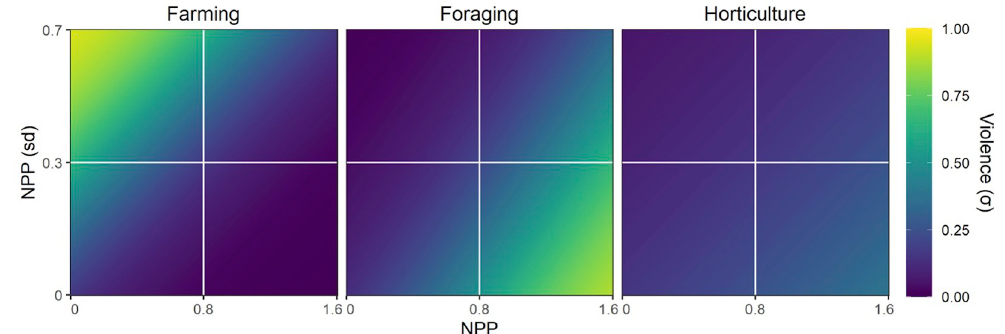
Fig 4. Model results showing the predicted response of proportional violence (PV) for each subsistence mode to every combination of mean environmental productivity (NPP) and the standard deviation in environmental productivity (NPP SD). Predicted values are constrained to their observed range in the data. Marginal response plots for each MoS are available in S1